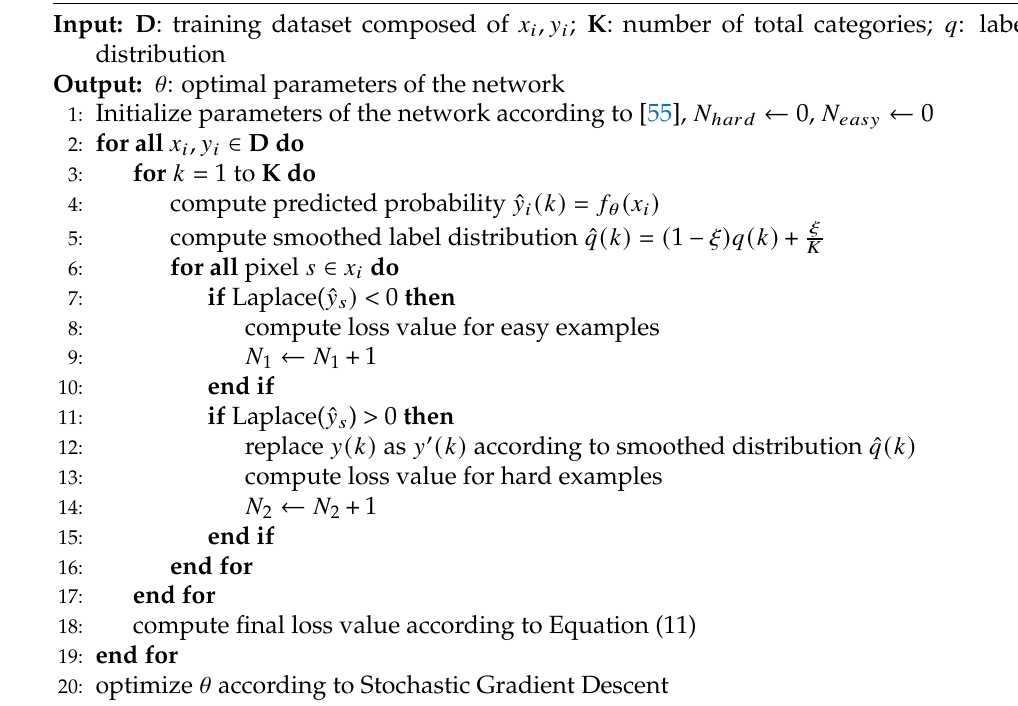
Algorithm 1 Adaptive Edge Loss